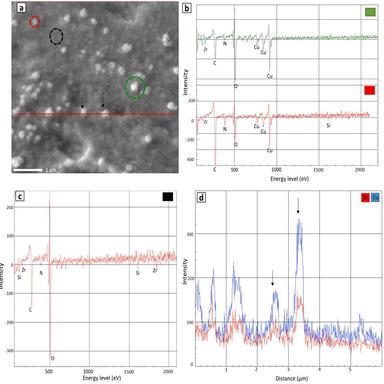
The SEM image of the treated sample measured area (a), the differentiated FEG-AES spectra of red and green spots on panel a (b), the differentiated FEG-AES spectra of black spot on panel a (c) and the FEG-AES line profiles of Cu, Zr, and N (d) corresponding to the red line on panel a. The black arrows on (a) and (d) show the correlated spots in the image and the line profile. (For interpretation of the references to color in this figure legend, the reader is referred to the web version of this article.)